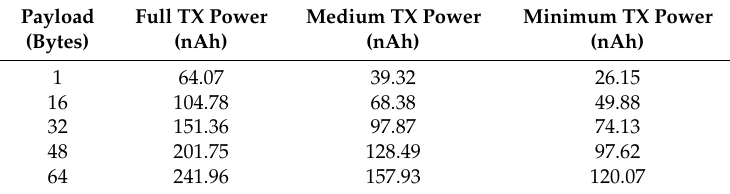
Table 5. Transmission electric charge for several payloads.